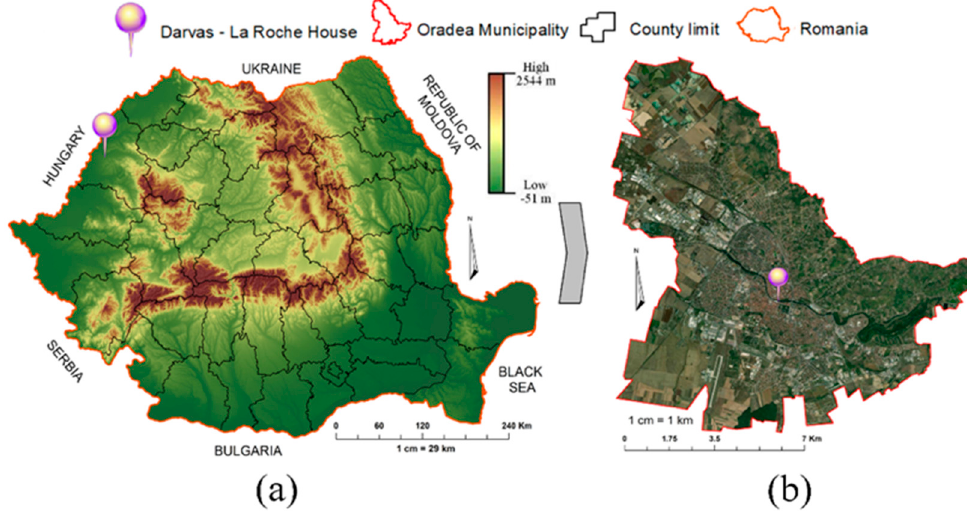
Figure 1. Location of the Darvas-La Roche House at the level of country (Romania) ( a ) and the Municipality of Oradea ( b ) .